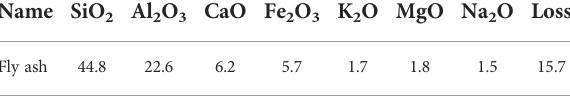
TABLE 1 Composition analysis of raw materials (XRF unit: %).